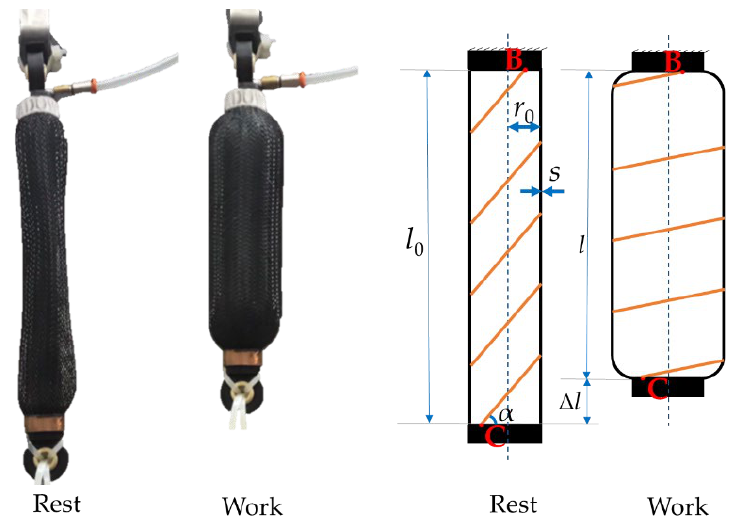
Figure 1. McKibben artificial muscle at resting and working condition. r 0 , l 0 , l , and s are, respectively, the initial radius, the nominal length, the working length, and the thickness of the inflatable chamber; Δ l is the contraction of the actuator; α is the winding angle of the fibers; B and C are the connections between the inextensible fiber and the upper and bottom head, respectively.